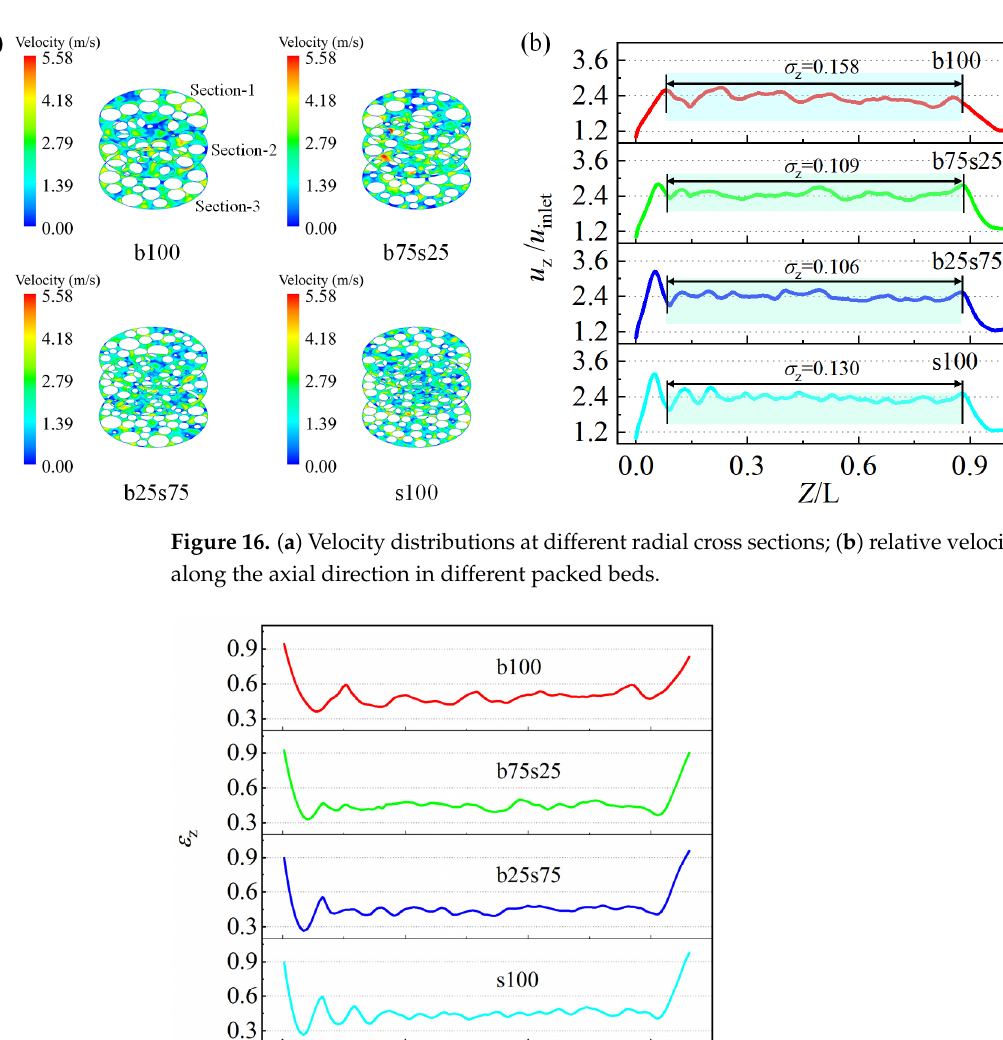
Figure 15. Schematic diagram of the selected sections in a packed bed.